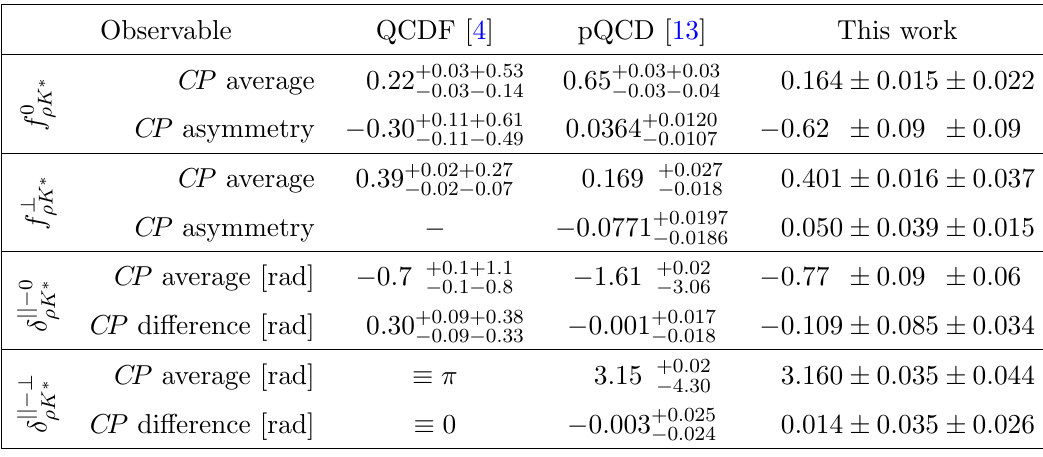
Table 4. Comparison of theoretical predictions for the B 0 (cid:26) (770) 0 K (cid:3) (892) 0 mode with the ! results obtained from this analysis. It should be noted that the theoretical predictions involving the CP averaged value of (cid:14) ? have been shifted by (cid:25) on account of the di(cid:11)erent phase conventions (cid:26)K (cid:3) used in the theoretical and experimental